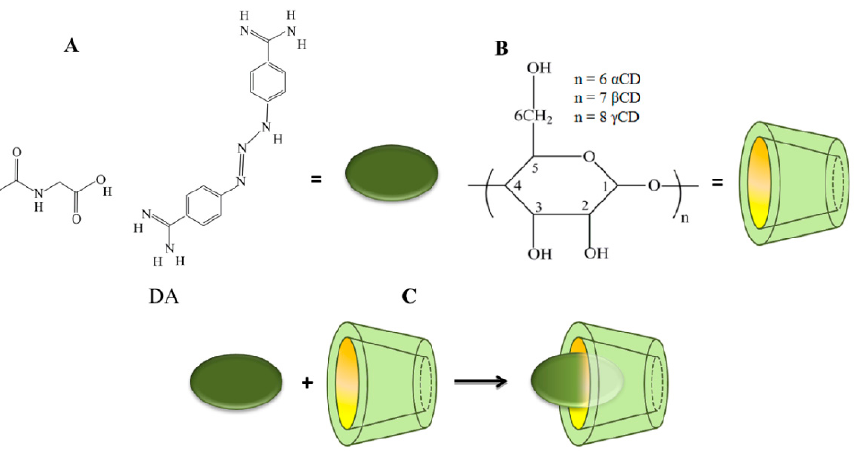
Figure 1. The chemical structures of: ( A ) DA, ( B ) β CD, and ( C ) schematic representation of the inclusion complex formation.